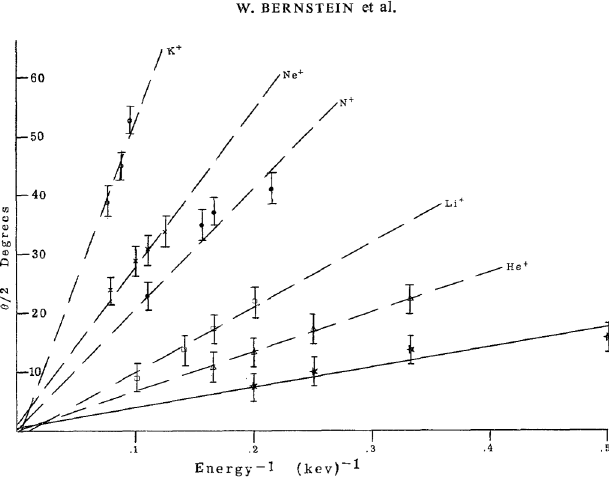
.FIG. 3. Measured straggling normalized to Bohr straggling values for protons (open symbols) and antiprotons (closed sym- bols) in solid aluminum foils, reproduced from [22]. The solid line shows the predictions for antiprotons of a binary collision theory for a perfect foil, while the dashed line shows predictions based on a realistic level of foil inhomogeneities. The Barkas effect is